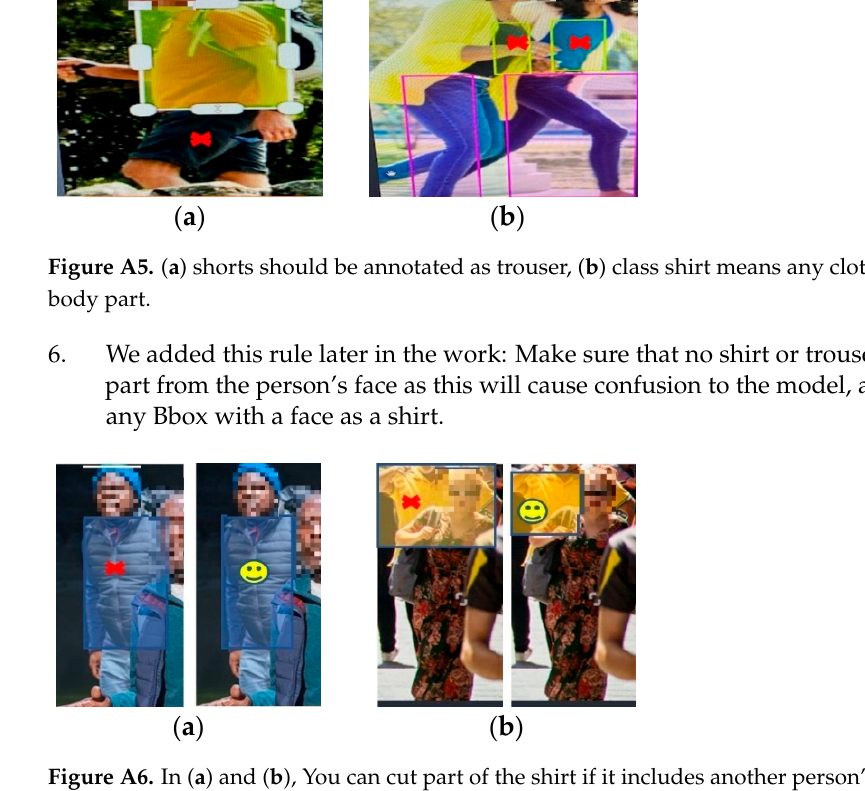
Figure A6. In ( a ) and ( b ), You can cut part of the shirt if it includes another person’s face.